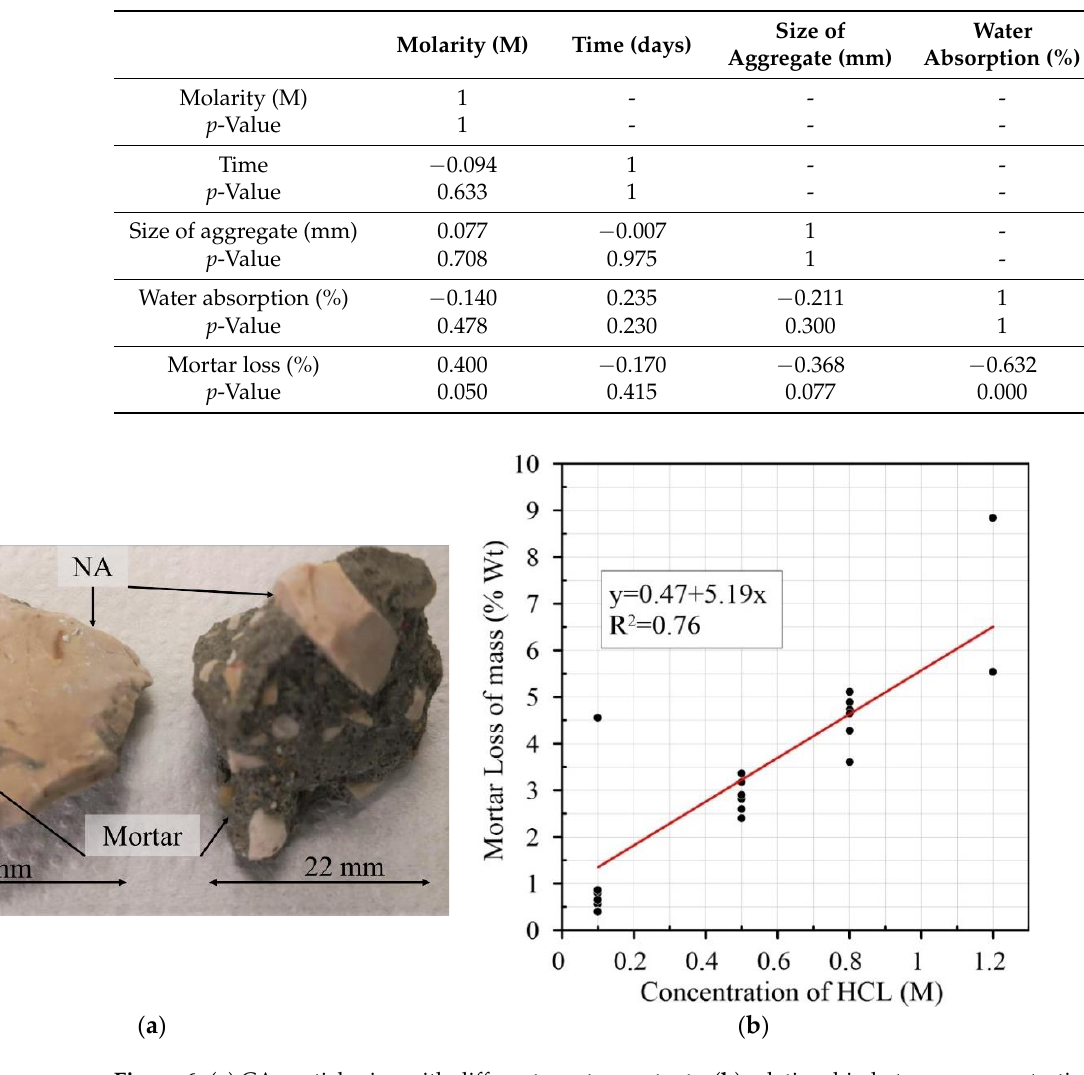
Table 3. Pearson correlation for RCA treated HCl.